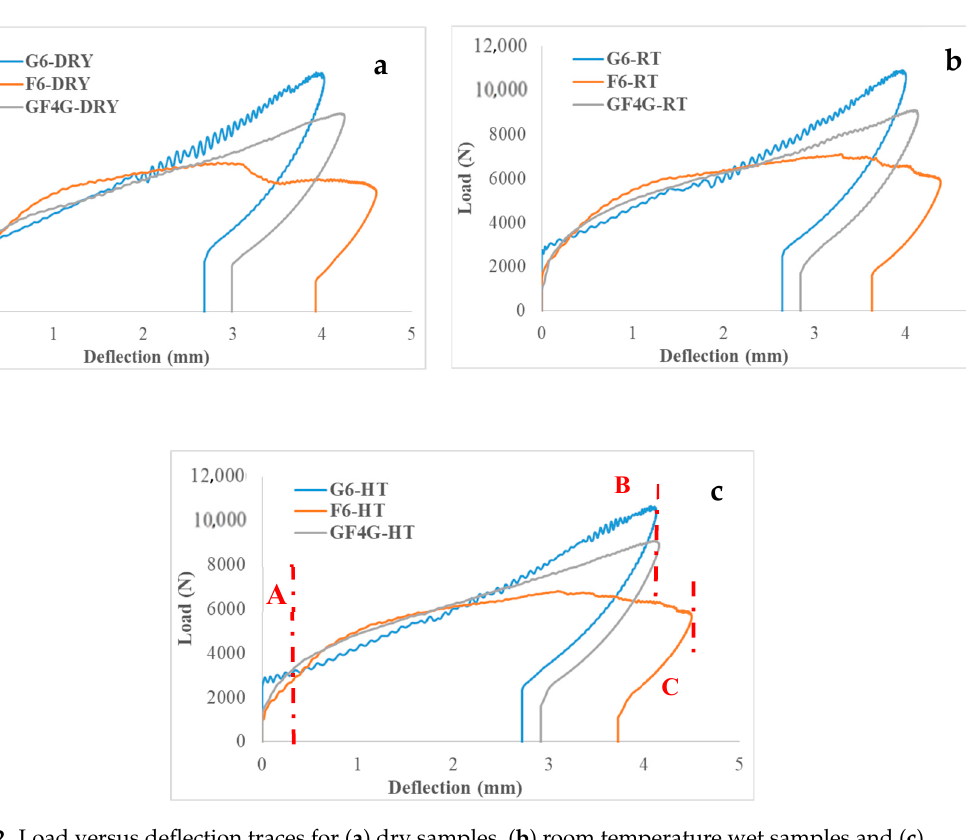
Figure 2. Load versus deflection traces for ( a ) dry samples, ( b ) room temperature wet samples and ( c ) high temperature wet samples. Table 2. Maximum load and maximum deflection of dry samples and two condition wet samples.